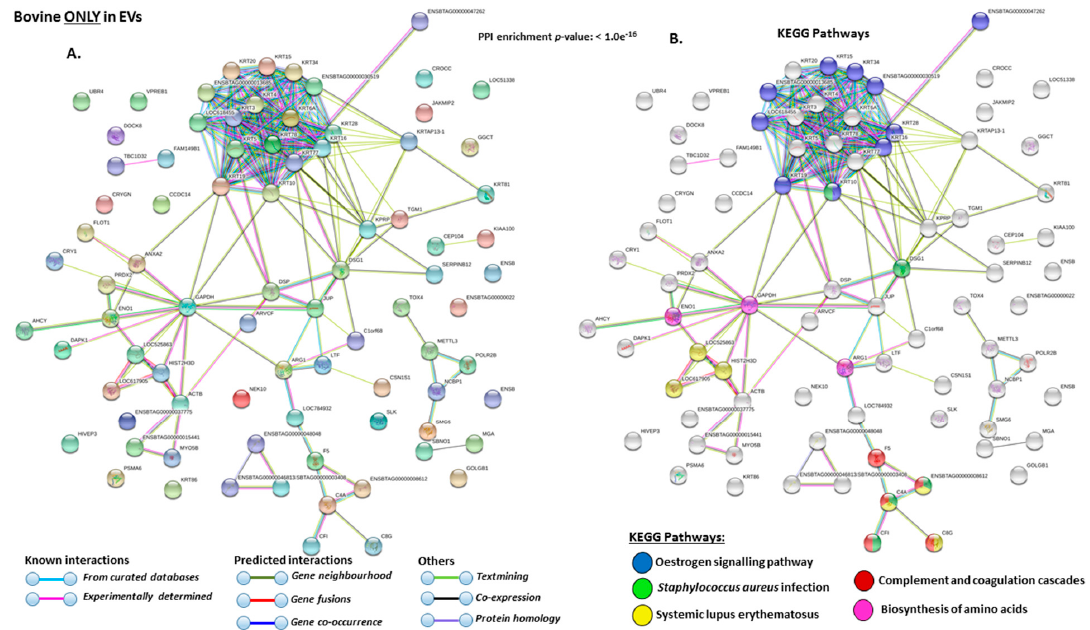
Figure 7. Protein–protein interaction networks of deiminated protein candidates identified in bovine serum-EVs only (not identified in total serum). Protein–protein interactions were reconstructed based on both known and predicted interactions by STRING analysis. ( A ) Query proteins are indicated by the coloured nodes and represent the first shell of interactors. ( B ) KEEG pathways relating to the identified deiminated proteins and reported in STRING are highlighted (see colour code included in the figure). The coloured lines highlight which protein interactions are identified through known interactions (this refers to curated databases, experimentally determined), through predicted interactions (this refers to gene neighborhood, gene fusion, gene co-occurrence) or through co-expression, text mining or protein homology (the colour key for connective lines is included in the figure).